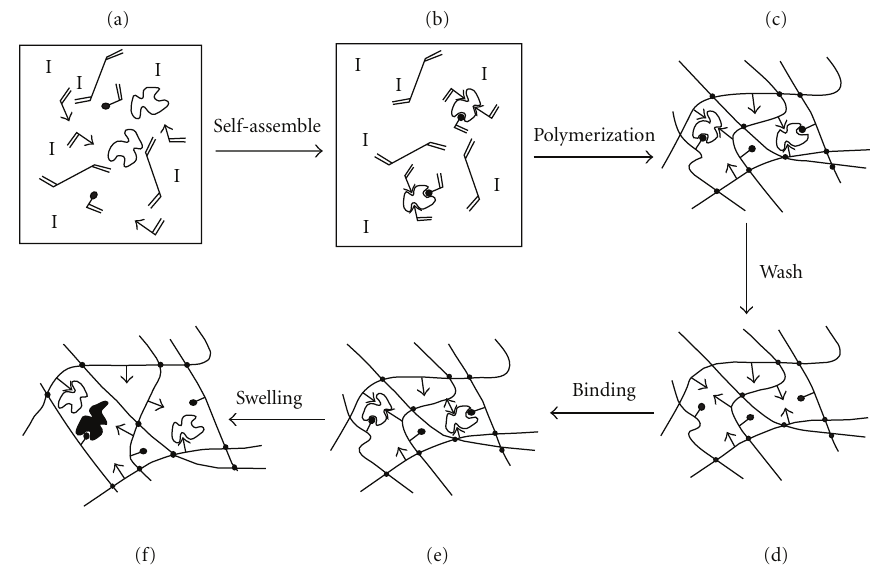
Figure 4: Imprinting process. (a) Solution mixture of template, functional monomer(s) (triangles and circles), crosslinking monomer, solvent, and initiator (I). (b) The prepolymerization complex is formed via covalent or noncovalent chemistry. (c) The formation of the network. (d) Wash step where original template is removed. (e) Rebinding of template. (f) In less crosslinked systems, movement of the